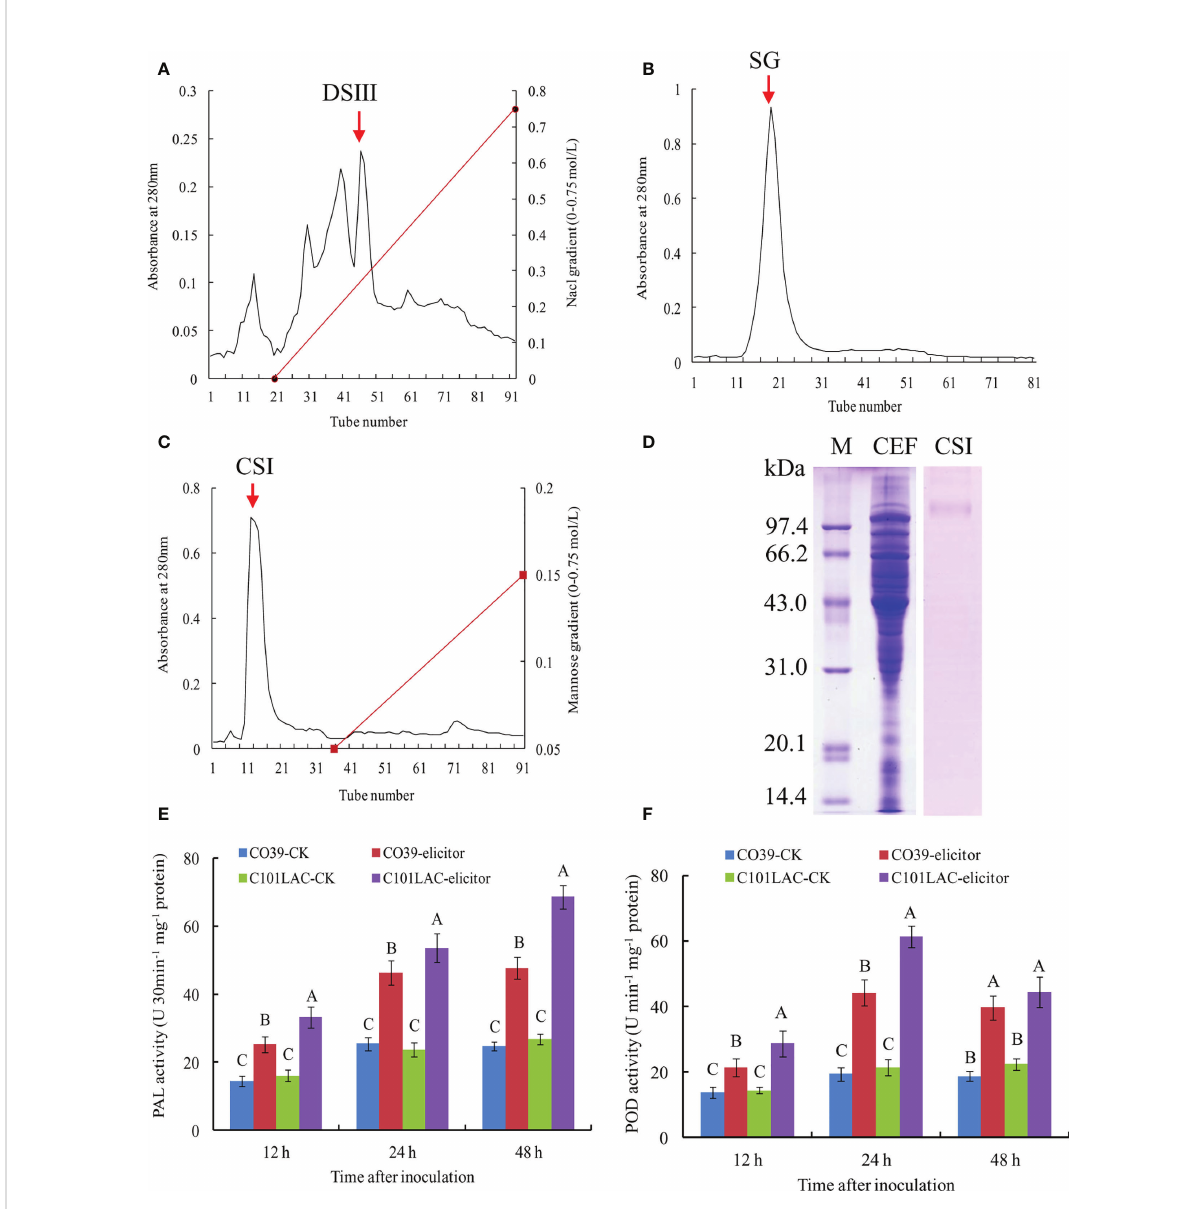
FIGURE 1 Puri fi cation of MoVcpo from M. oryzae . (A) Chromatography on DEAE-Sepharose FF of the crude elicitor fraction. Elution was performed with a NaCl gradient. (B) Gel permeation chromatography on Sephedex G-75 of DEAE-Sepharose FF fraction DSIII. (C) Chromatography on ConA- Sepharose 4B of Sephadex G-75 fraction SG. Elution was performed with a mannose gradient. DSIII, SG and CSI were indicated by an arrow. Absorbance of the material was monitored at 280 nm. (D) SDS-PAGE analysis of the puri fi ed elicitor protein using CBB staining. Fifteen m g total proteins per lane was loaded. Lane M, marker; lane CEF, the crude elicitor fraction; lane CSI, the puri fi ed elicitor. (E) PAL activity of rice leaves induced by the puri fi ed elicitor. (F) POD activity of rice leaves induced by the puri fi ed elicitor. Values are the means ( ± SE) based on three independent experiments and bars indicate standard deviations. Different letters indicate statistical signi fi cance ( p < 0.05) using Duncan ’ s new multiple range